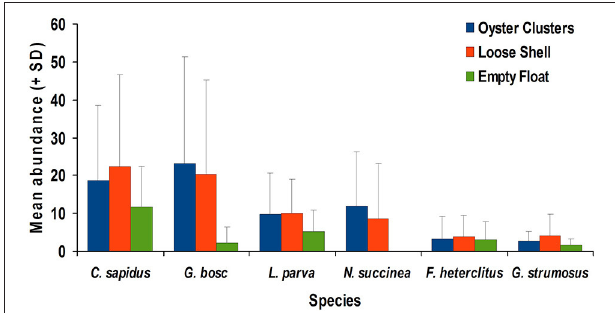
FIGURE 11 | Average abundance ( + std) for six species collected from Little Assawoman Bay in comparative study using live oyster clusters, loose shells, and empty floats. Data were pooled across months (Marenghi,